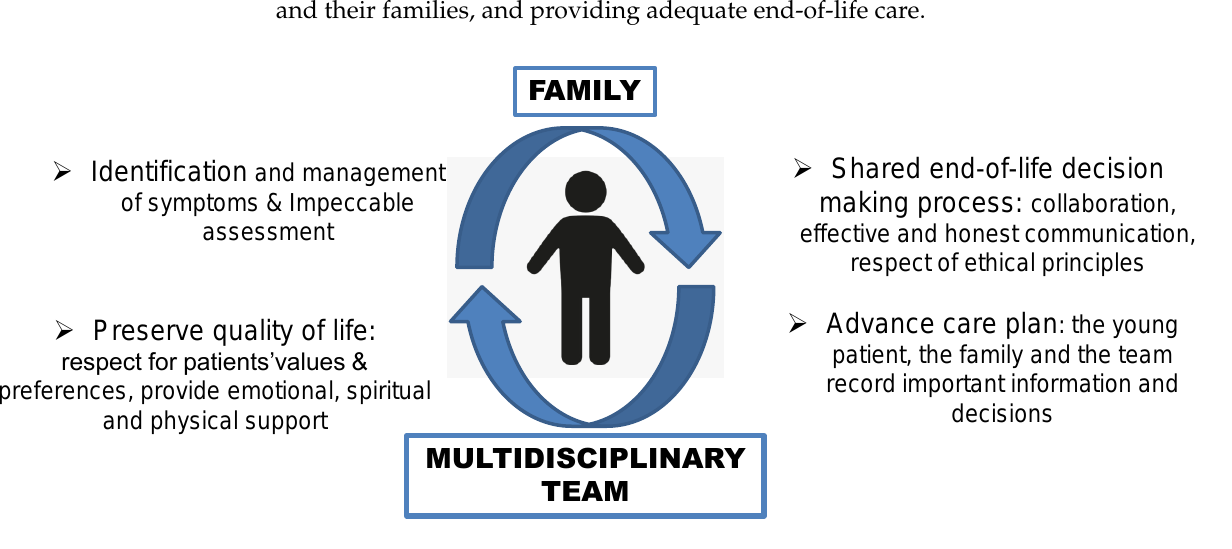
Figure 1. Visual summary of palliative